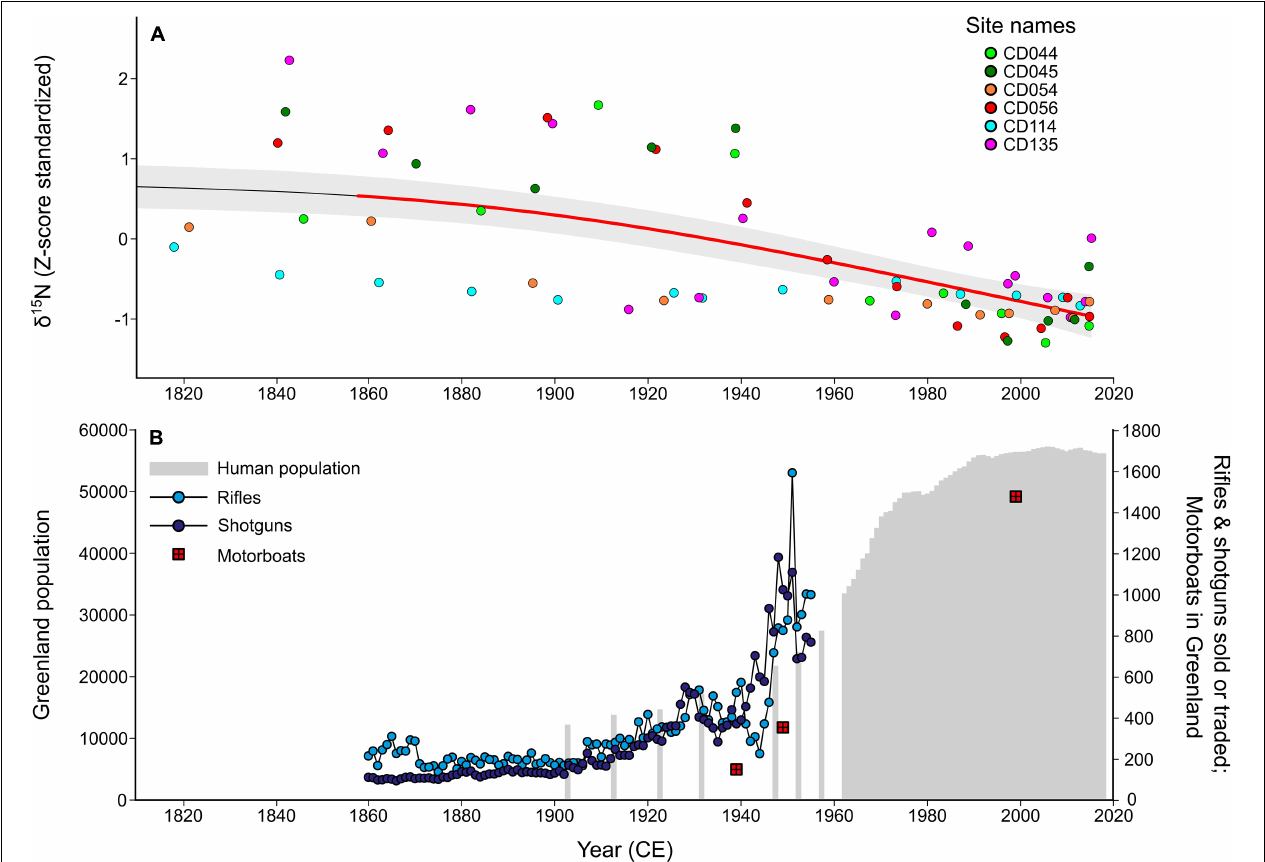
FIGURE 6 | The effect of increasing human population and associated increased availability of rifles, shotguns, and motorboats on eider populations in Greenland, modified from Hargan et al. (2019). The dataset is abridged from 1820 to 2018. (A) Historical sedimentary stable nitrogen isotope ratios (Z-score standardized) of the study sites in Cape Dorset, southwest of Baffin Island in Hudson Strait. The overall trend in the study region is demonstrated using a generalized additive model (GAM), and the period of significant decline is shown in bolded red. (B) Increase in human population and rifle, shotguns, and motorboats sold or traded in Greenland. Note the corresponding trends of decreasing eider populations as determined by δ 15 N and increase in human population and the associated hunting